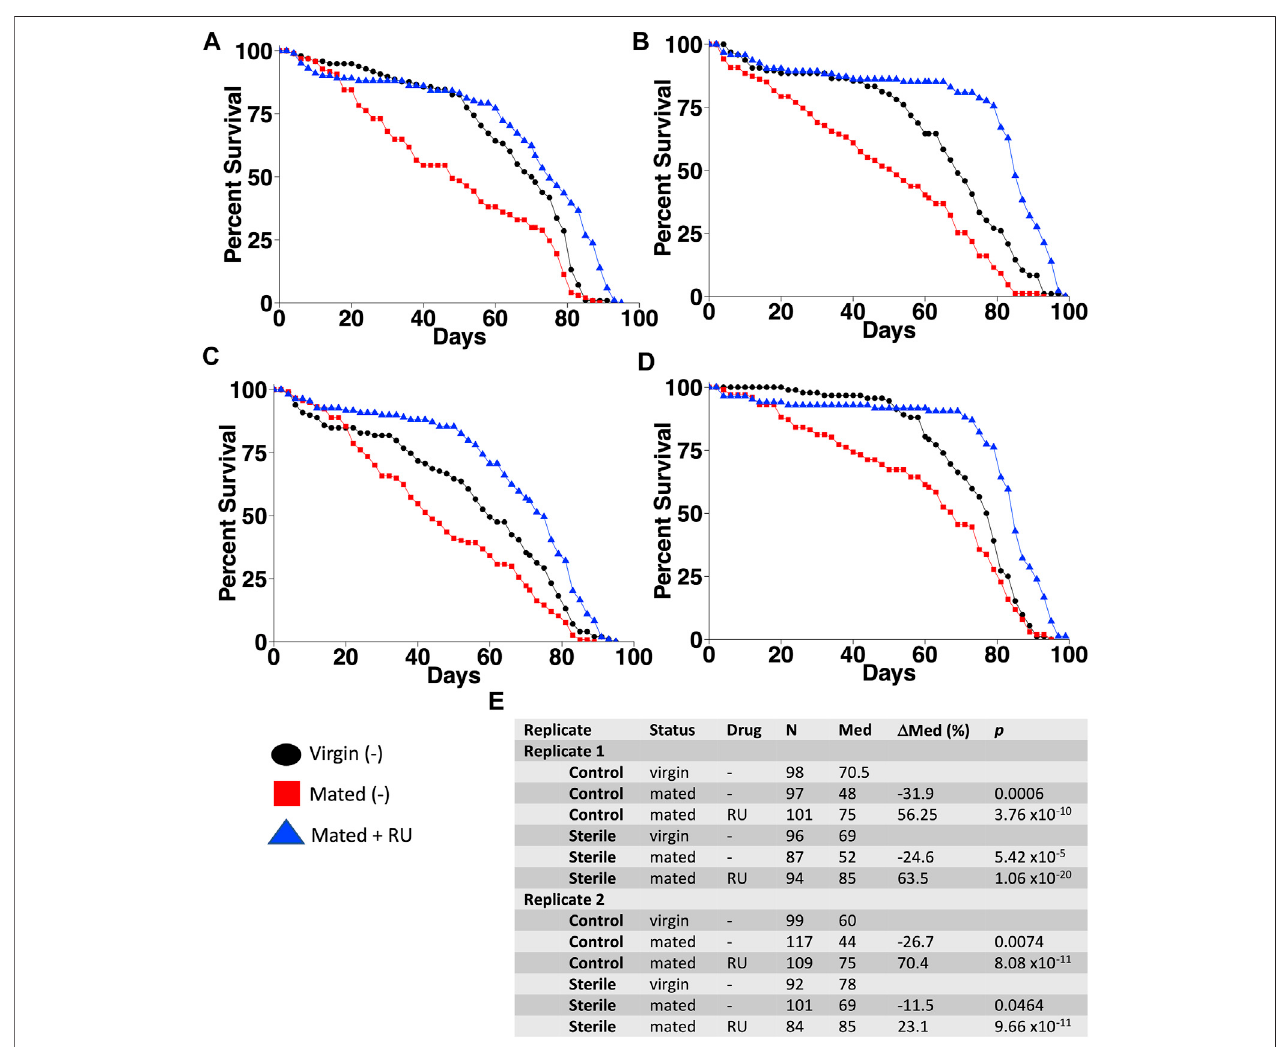
FIGURE 1 | Additive life span bene fi t from egg sterilization and mifepristone. Life span was assayed in virgin females, mated females, and mated females plus mifepristone/RU486(RU),using controlcultureconditions (A,C) and usingeggsterilization and autoclaved media (B,D).(A) Controlconditions, experiment 1. (B) Sterile conditions,experiment1. (C) Controlconditions,experiment2. (D) Sterileconditions,experiment2. (E) Statisticalsummary.Foreachexperiment,matediscomparedto virgin, and mated plus drug is compared to mated. Statistical test: log-rank; p- value for signi fi cance with two comparisons is 0.025.